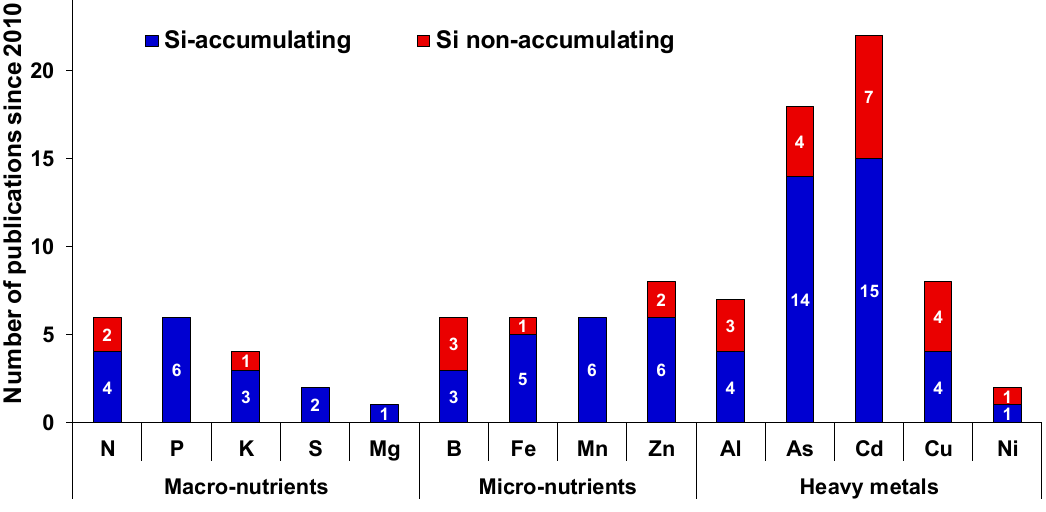
Figure 1. Number of major published articles indicating only the cross-talk between Si and nutritional stress since 2010. For each element, the number inside each bar indicates the number of published work in Si-accumulating (blue bar) or Si-non-accumulating species (red bar).